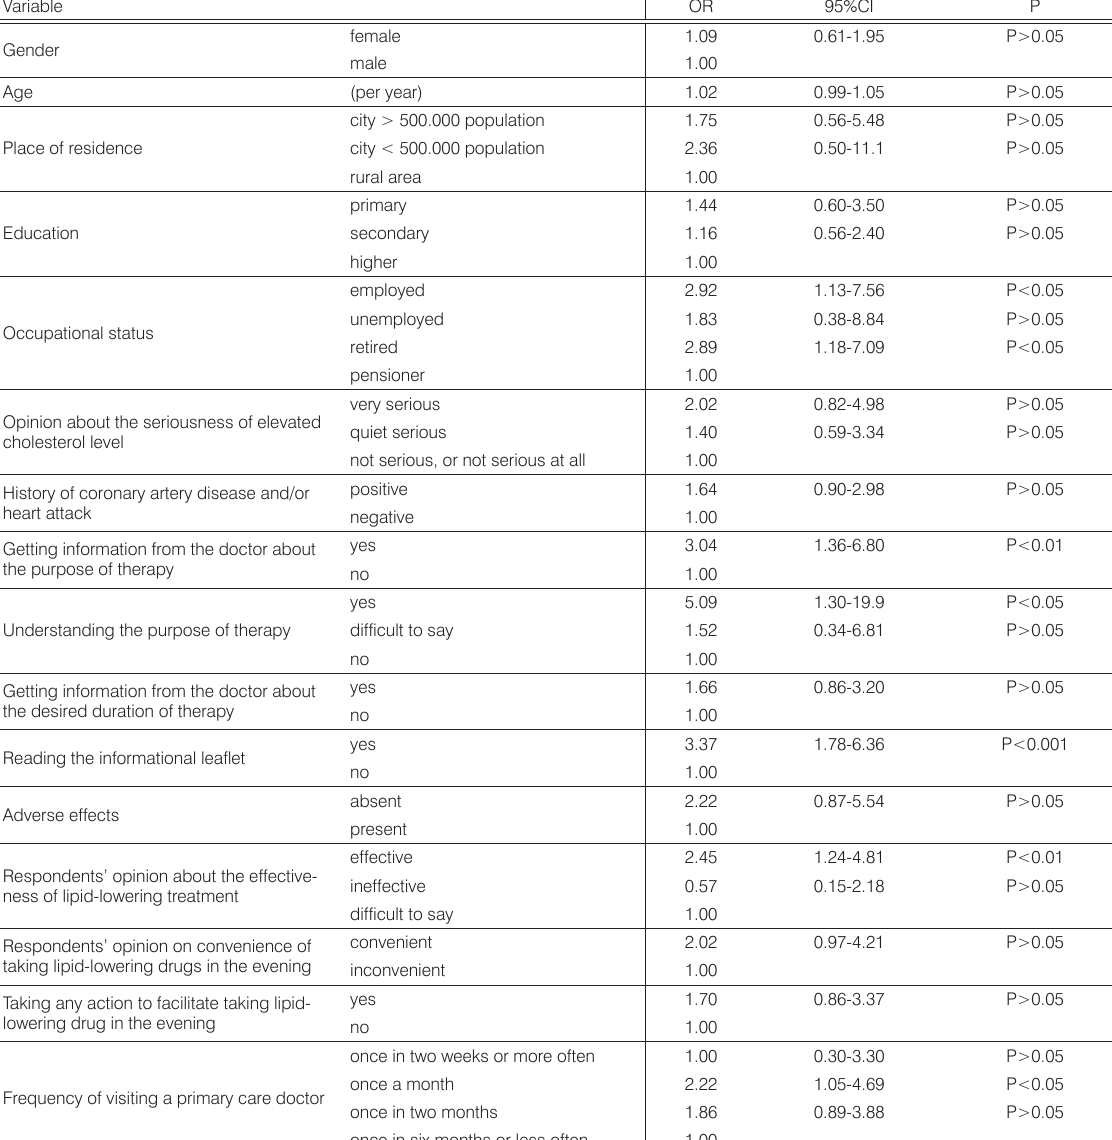
Table 7. Logistic regression results for adherence to lipid lowering treatment as a dependent